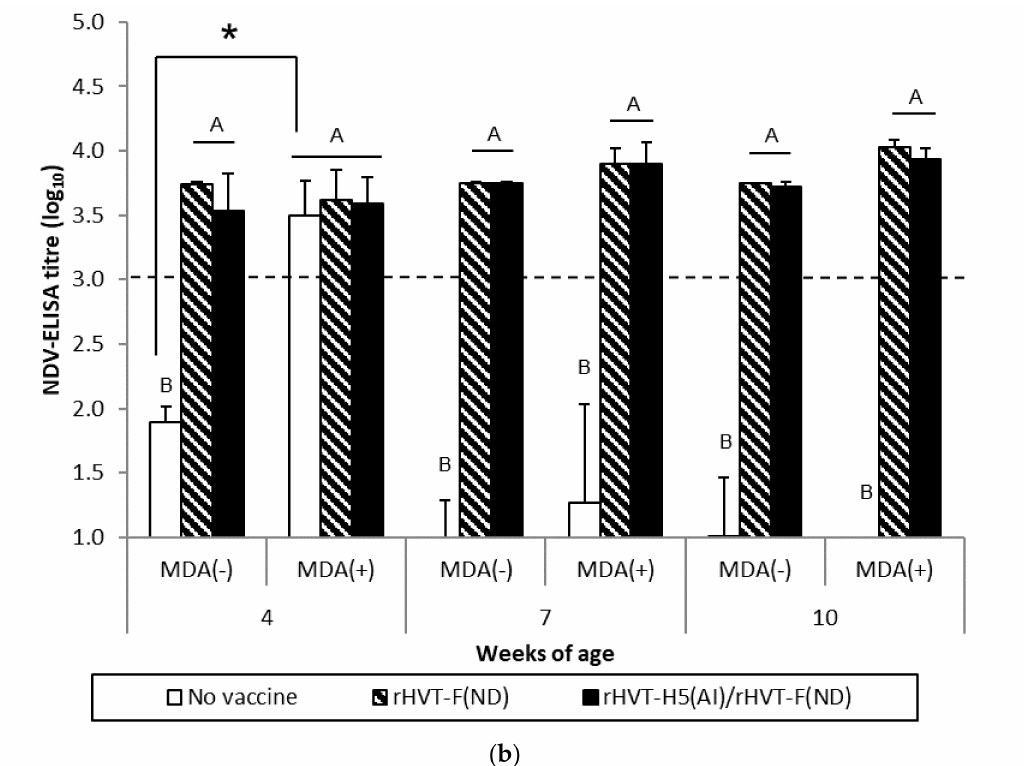
Figure 1. NDV-specific antibody responses measured in ND-ELISAs for WL SPF chickens ( a ) and LBL layer chickens ( b ) vaccinated at day-old (experiments I and II, respectively) with rHVT-F(ND) or both rHVT-H5(AI) / rHVT-F(ND) vaccines. Data represent mean ± standard deviation of antibody titers (log 10 ) determined by ELISA at specified ages (n = 5). ND-ELISAs were performed according to